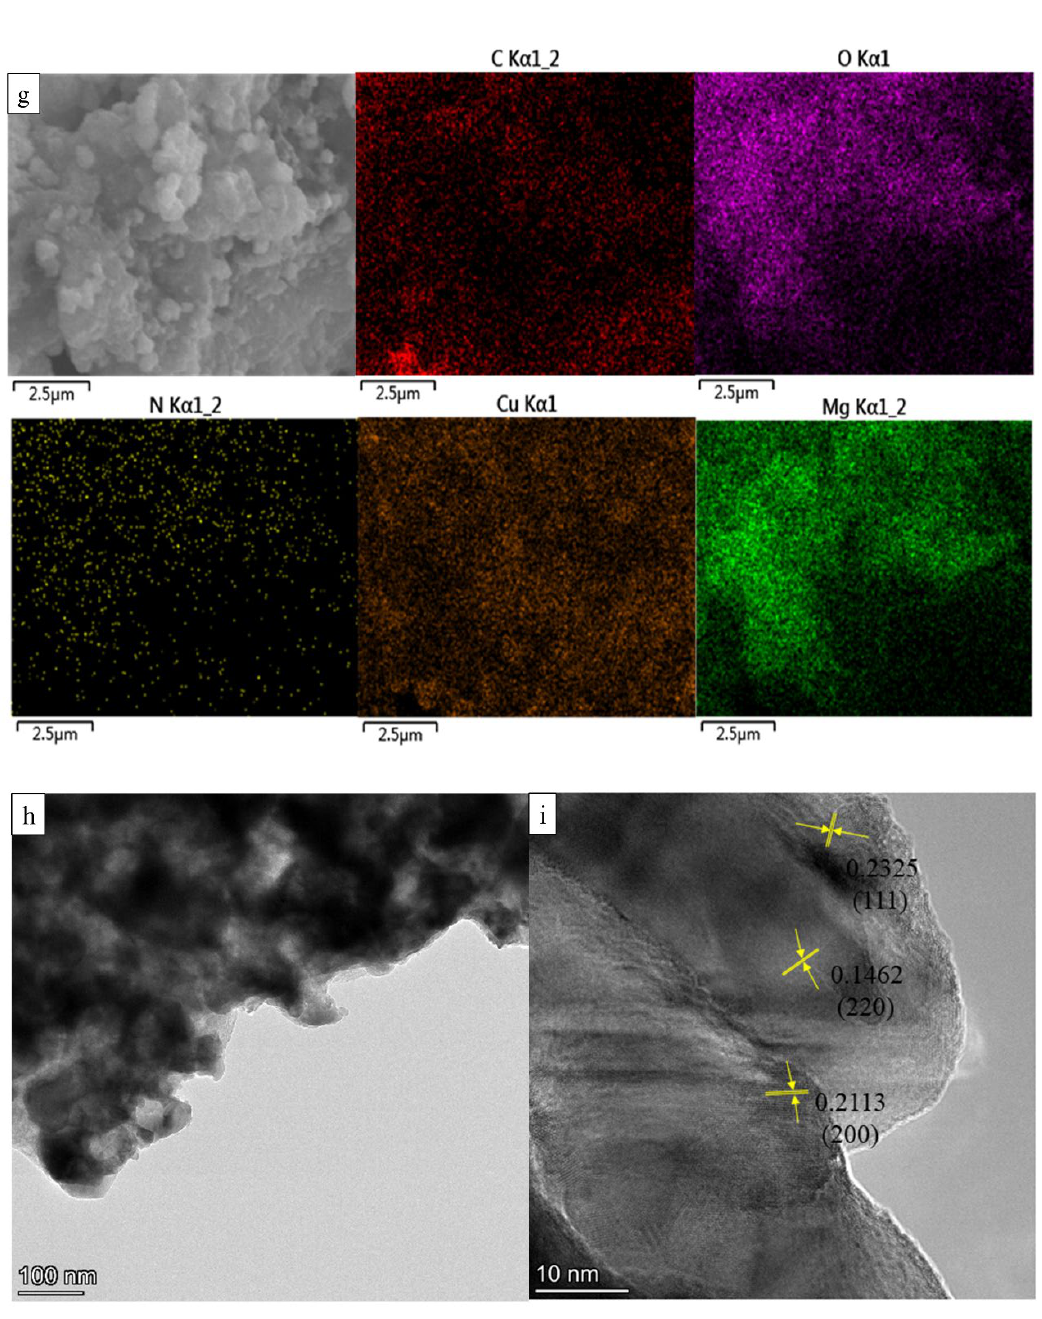
Figure 2. SEM image of CM ( a ), g-C 3 N 4 ( b ), CM/g-C 3 N 4 before ( c ) and after the reaction ( d ), C/g- C 3 N 4 ( e ), M/g-C 3 N 4 ( f ), EDS mapping of CM/g-C 3 N 4 ( g ), TEM image ( h ) and HRTEM image ( i ) of CM/g-C 3 N